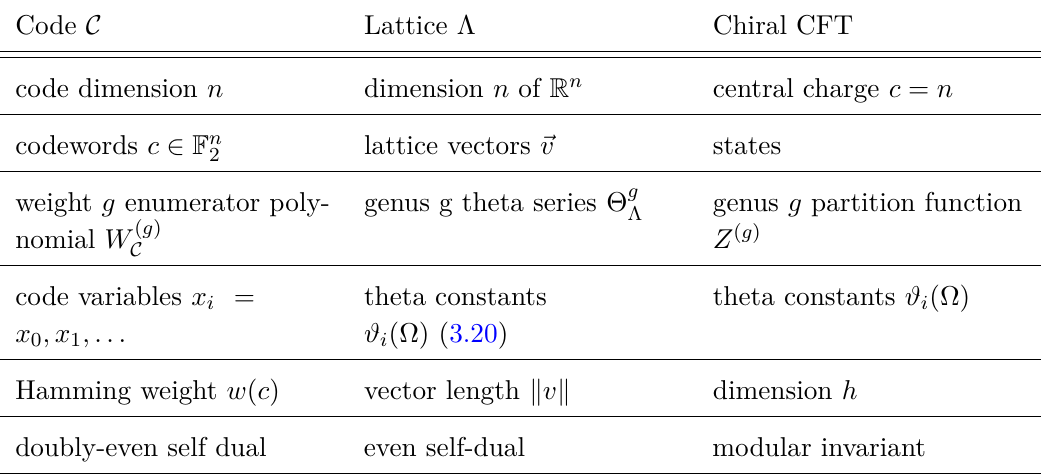
Table 1. Dictionary relating error correcting codes and